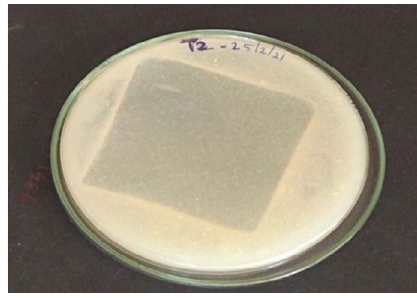
Fig. 5. PU sheet in solid medium with